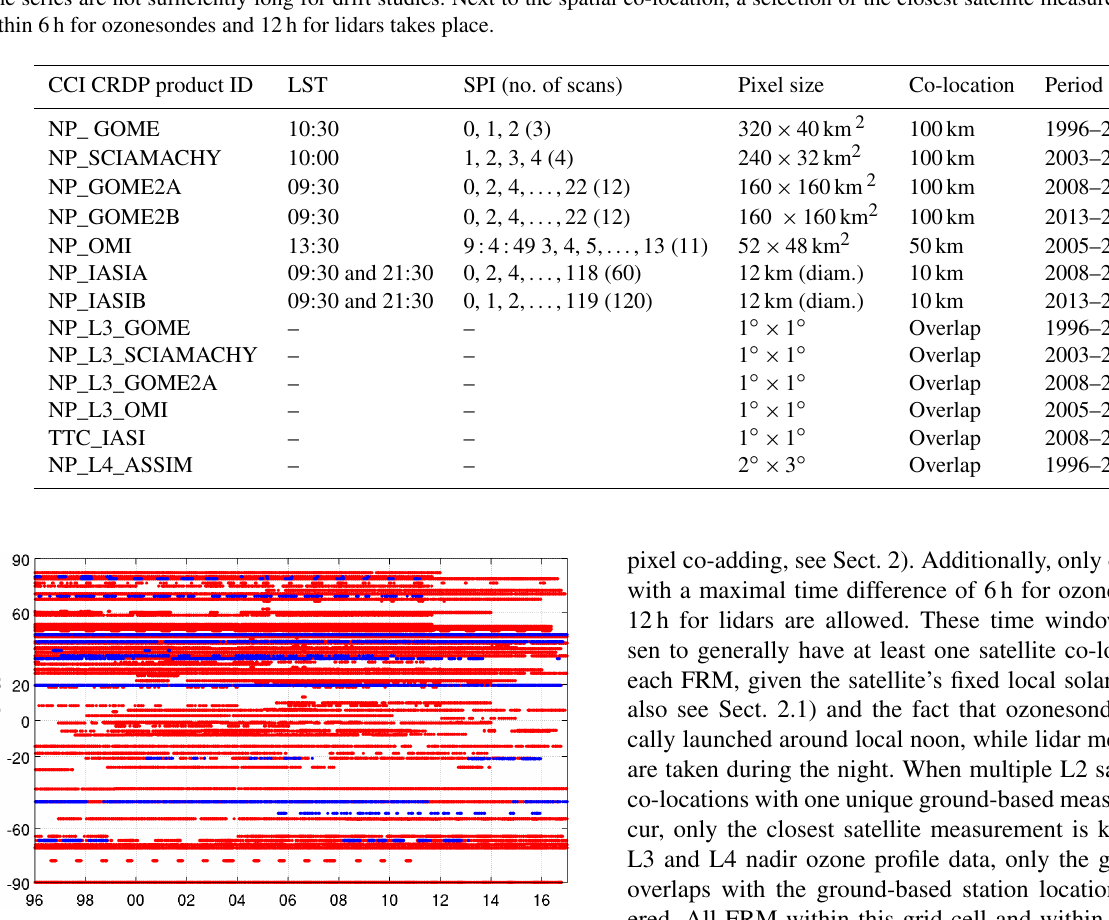
Figure 2. Latitude–time sampling (1996–2016) of the ground-based ozonesonde (red dots) and stratospheric ozone lidar (blue dots) mea- surements obtained from the NDACC, SHADOZ, and WOUDC ref- erence network